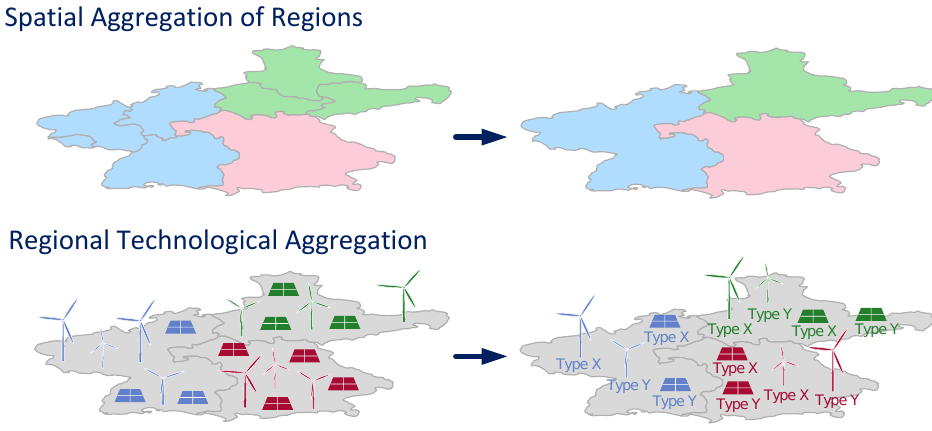
Figure 1. Pictorial description of the spatial aggregation of regions and technological aggregation within each newly-defined